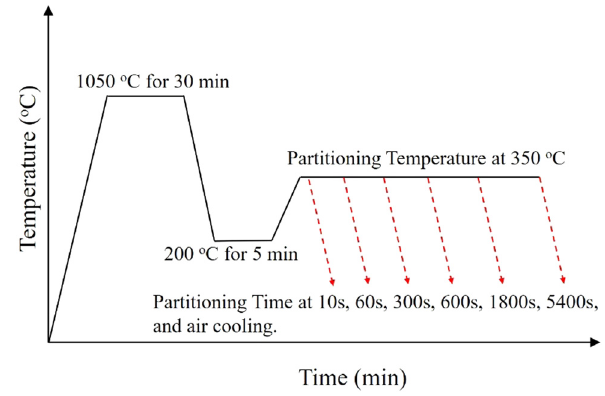
Figure 1: Schematic sketch of the